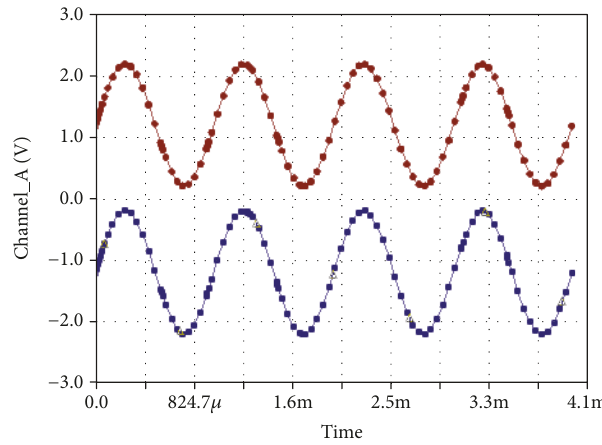
Figure 15: Transmitting and receiving waveforms.